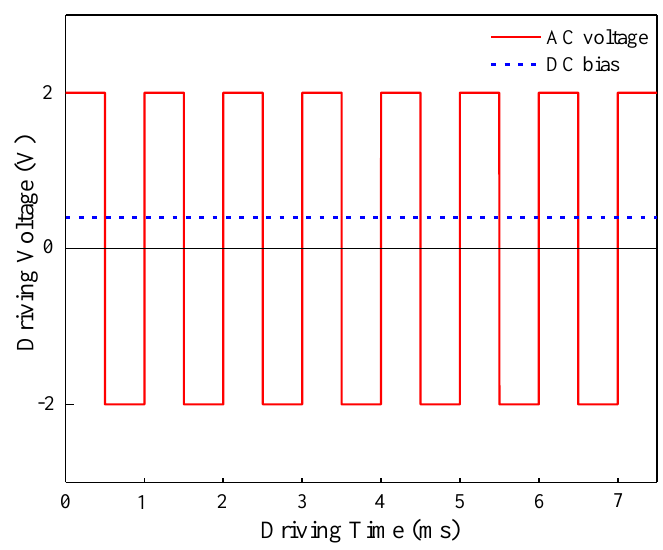
Figure 5. Driving voltage applied to the LC cell.